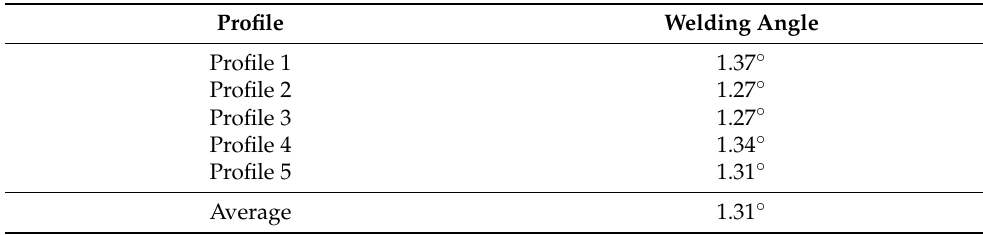
Figure 6. Distortion of five profiles after welding. Table 2. Welded sample: angular distortions.